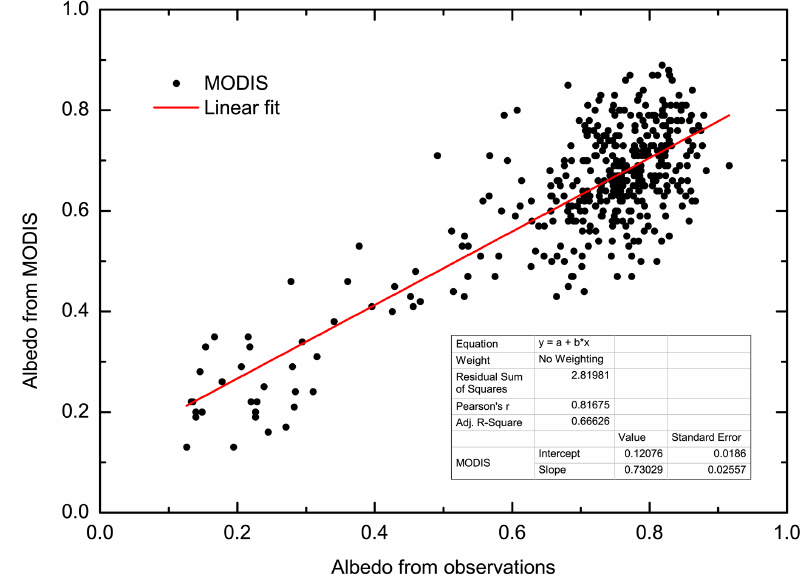
Figure 3. The albedo of the pixel including the AWS in Zhadang glacier derived from MODIS and that observed by AWS in 2011.